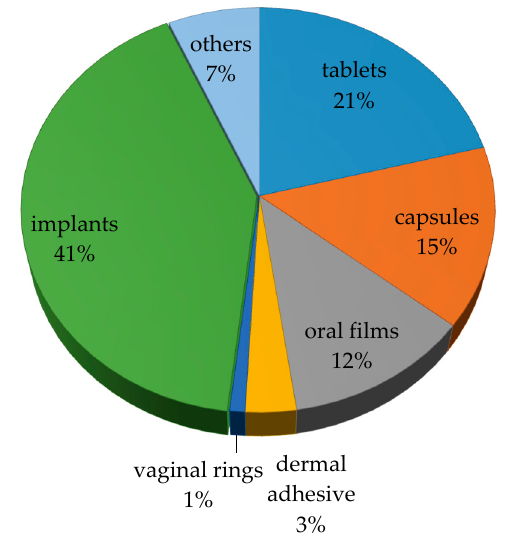
Figure 2. Pharmaceutical dosage forms printed by fused deposition modelling (FDM), as published between 2009 and 2019 (ScienceDirect ® ) (n = 613 publications).